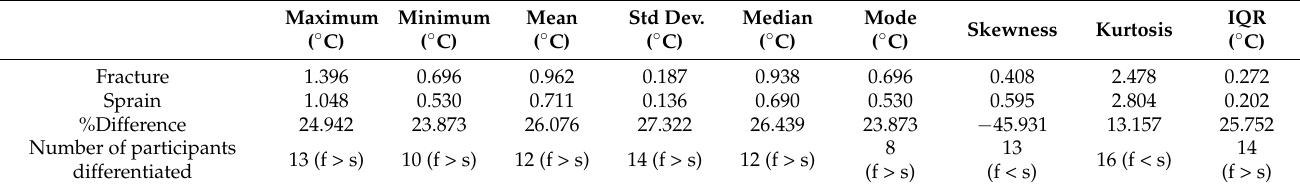
Table 1. Average differences between the injured and contralateral uninjured (reference) wrists for the statistical measures, the percentage difference and number of participants differentiated by the statistical measures (fracture (f), sprain